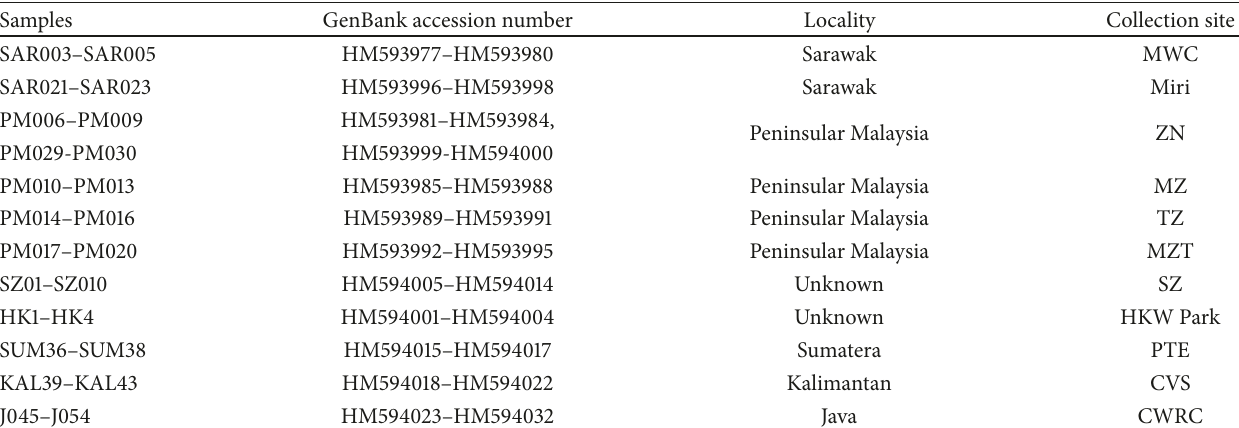
Table 1: Details of Cyt b -CR gene sequences obtained from GenBank involved in this study.